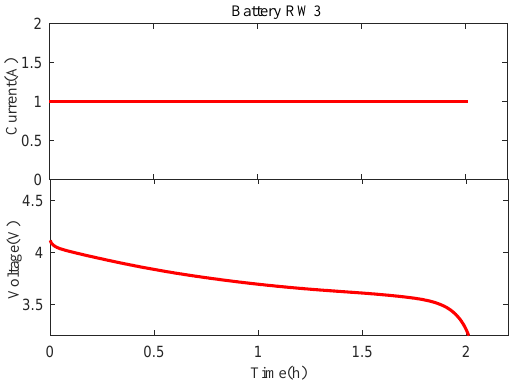
Figure 3. Example of the voltage curve when the load is constant during discharge process.